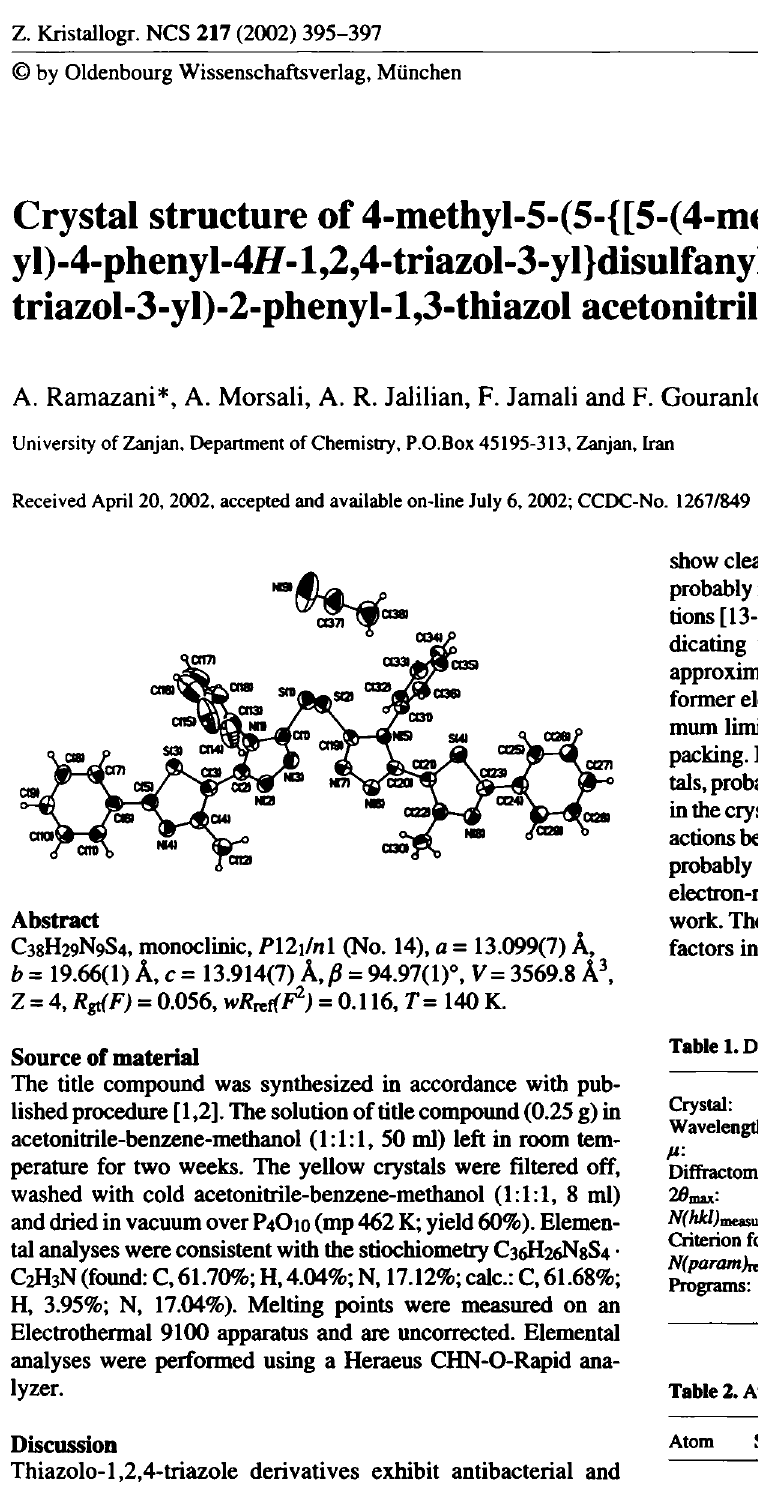
Table 2. Atomic coordinates and displacement parameters (in Â 2